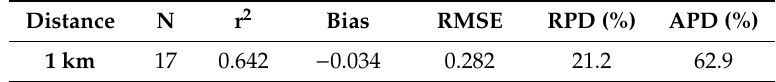
Figure 4. Comparison between in situ Chl a and satellite Ocean Colour–Climate Change Initiative (OC-CCI) Chl a product for the common match-ups. Table 2. Main statistics of the comparison between in situ and satellite Chl a products for selected match-ups obtained from the same day and a maximum distance of 1 km.